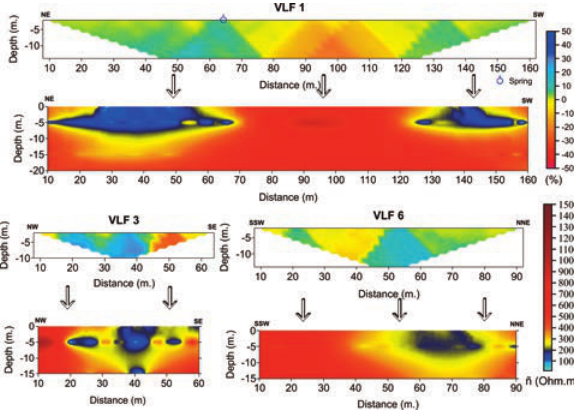
Figure 7. The Karous-Hjelt pseudo-sections of the selected pro- files VLF 1, VLF 3 and VLF 6 are represented. The respective re- sistivity section derived from inversion with Inv2DVLF software is also included (Initial resistivity 500 Ohm.m with 20 iterations. RMSVLF 1= 1.16%, RMSVLF 3=1.82%, RMSVLF 6=0.95%). Fre- quency: 23.4 KHz.